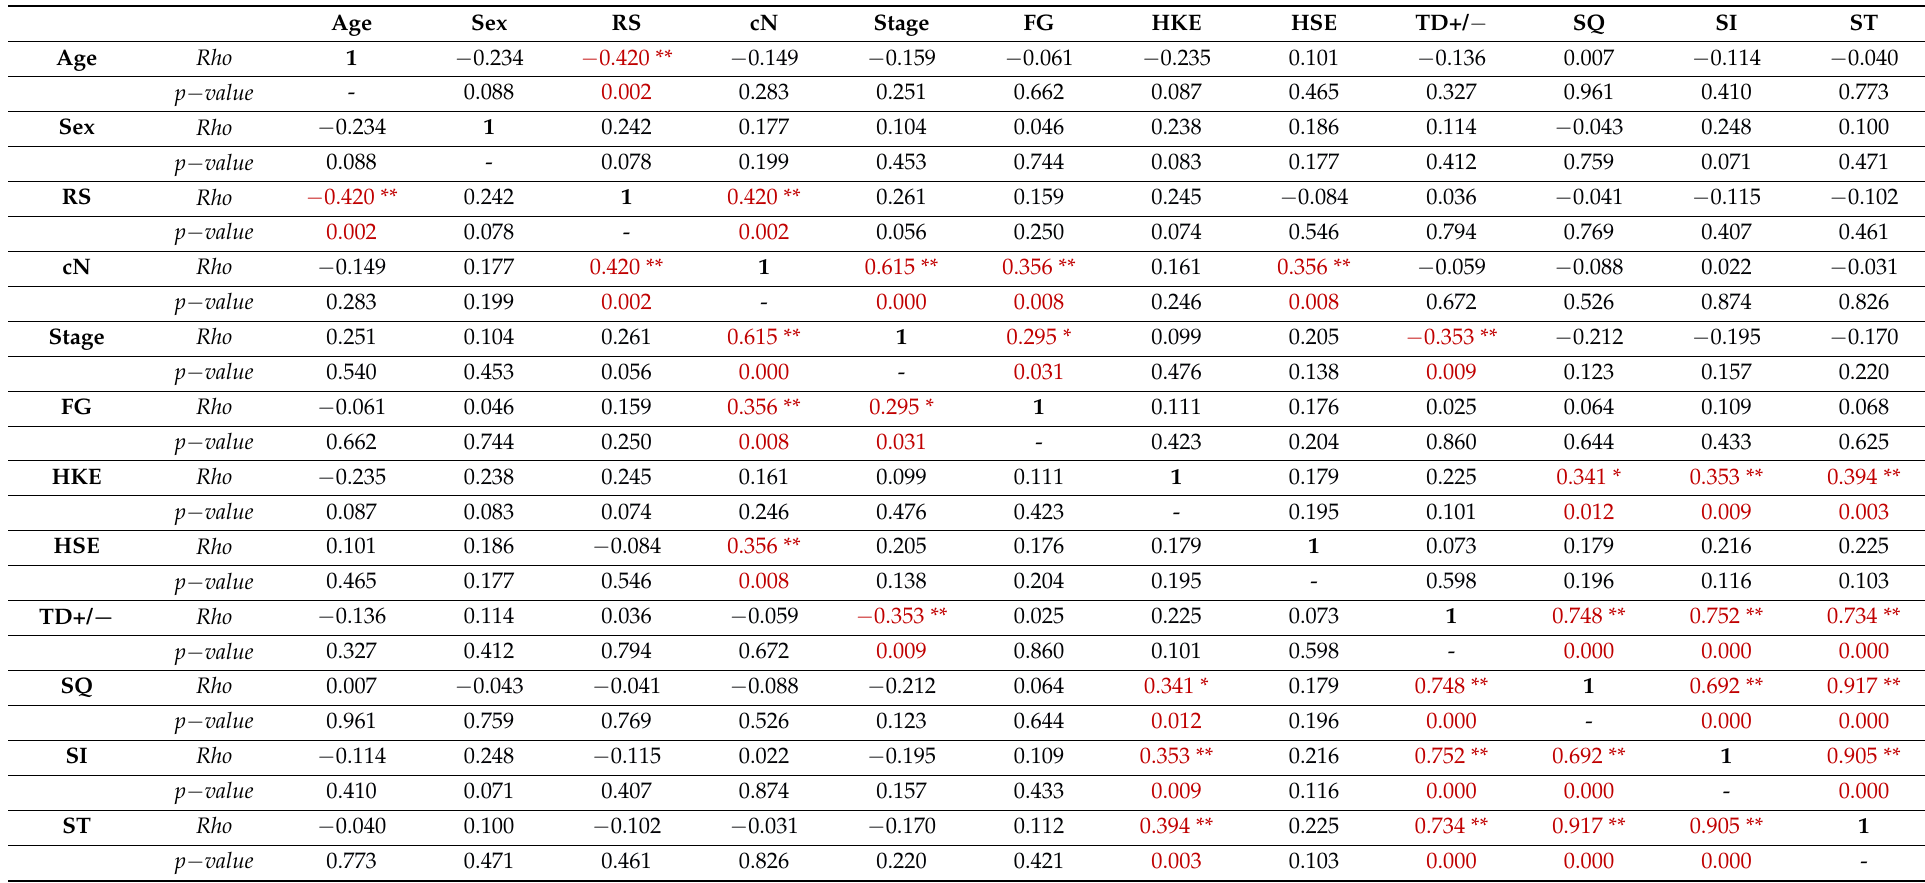
Table 4. Correlation analysis of the studied